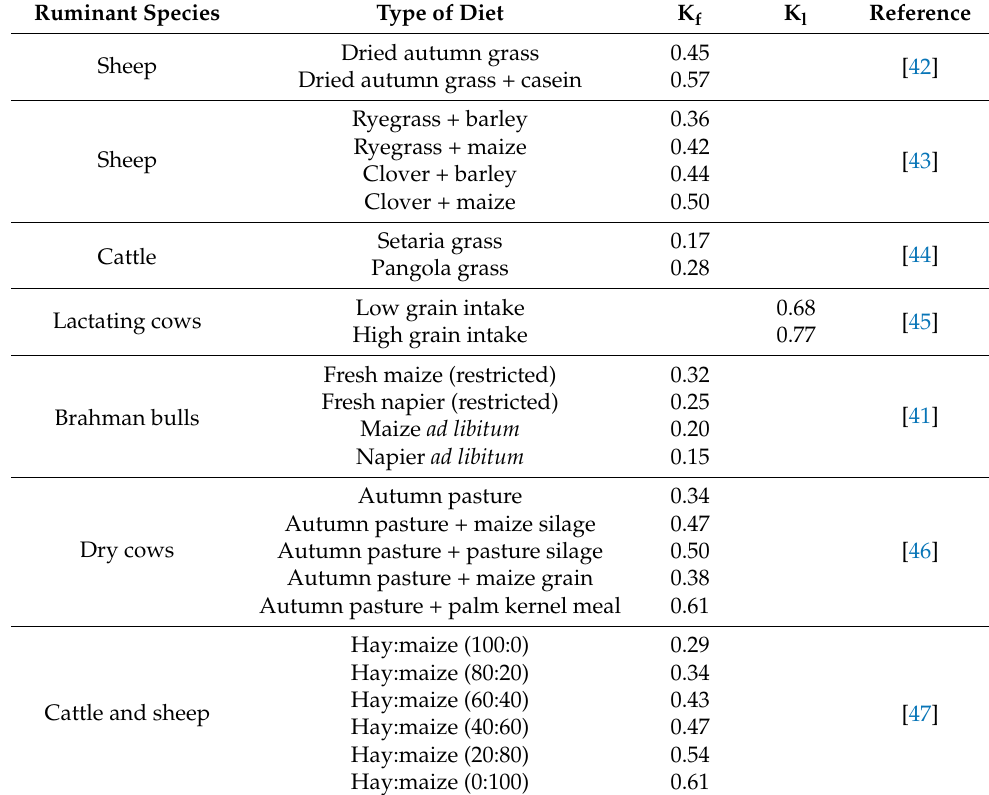
Table 4. Efficiency of utilisation of energy for retention (K f ) and lactation (K l ) on forage-based diets from feeding